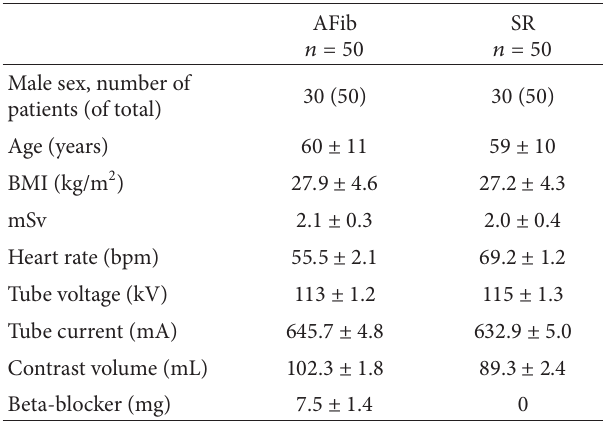
Table 1: Patient characteristics (patient baseline and CT acquisition